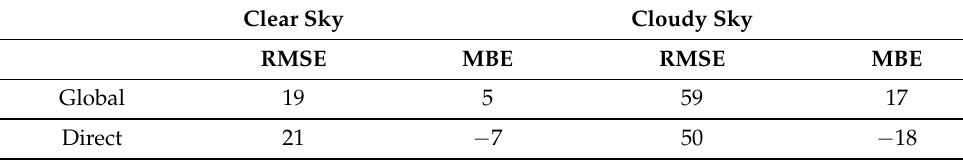
Table 1. Root Mean Square Error (RMSE) (in W m − 2 ) and Mean Bias Error (MBE) (in W m − 2 ) between simulated and observed global and direct irradiance obtained using [16]. Clear